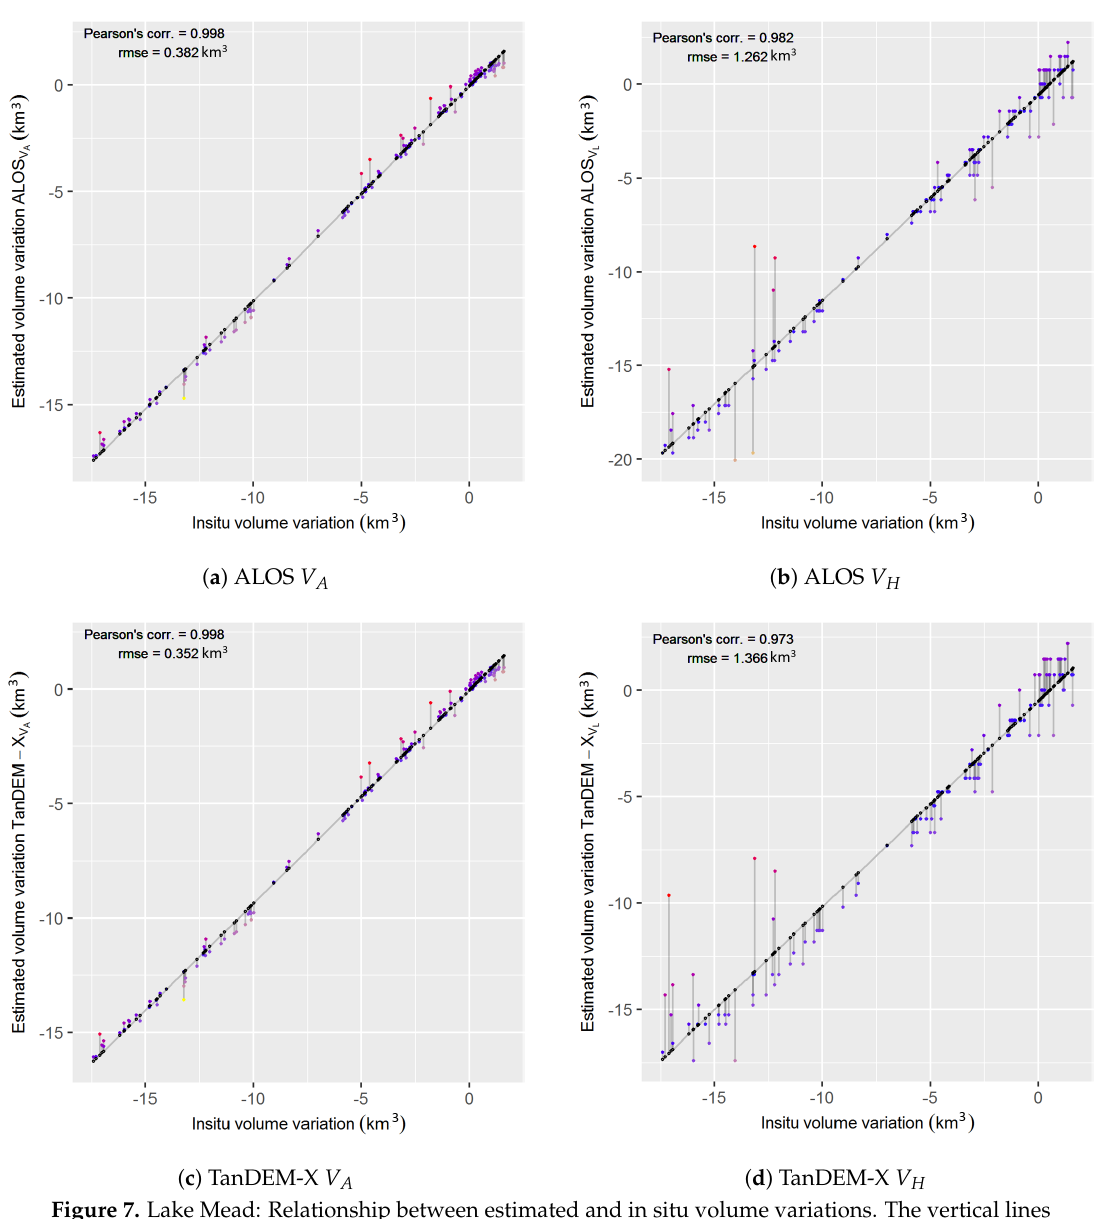
Figure 7. Lake Mead: Relationship between estimated and in situ volume variations. The vertical lines with darker color-codes indicate the lower standard deviation of the residuals from the regression line (lower RMSE). The lighter color-codes indicate higher deviations of estimated values from the in situ values and higher